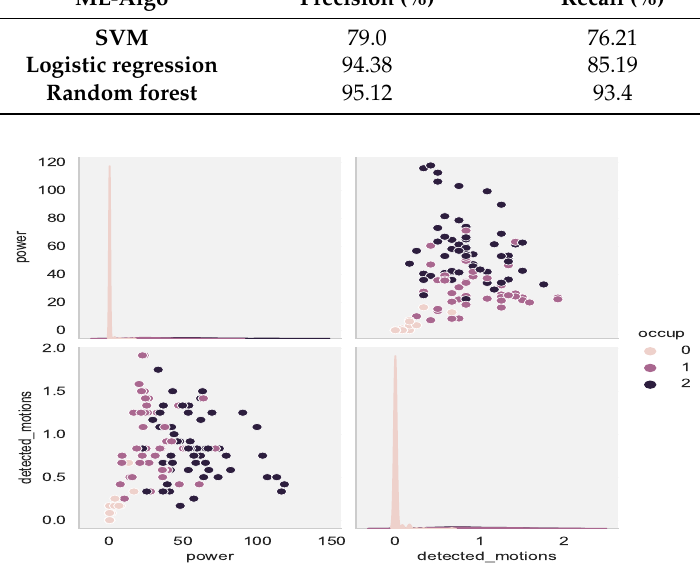
Figure 9. Pair-plot of power vs. detected_motions (avg per